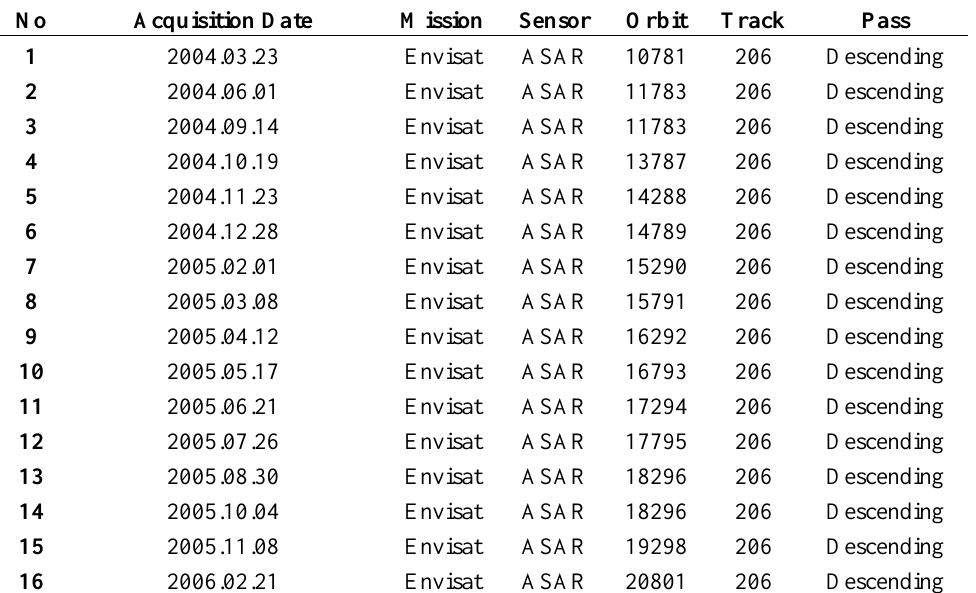
Table 1. List of used Envisat SAR images, date of acquisition and other specifications.